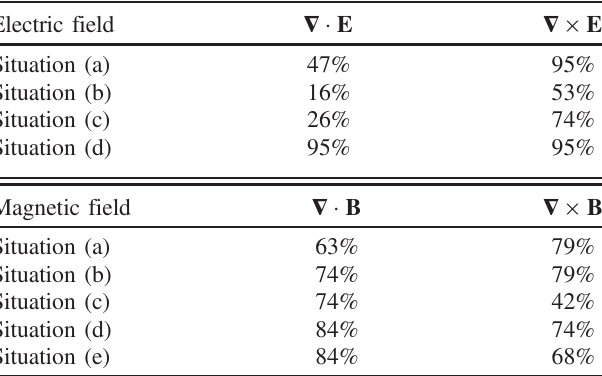
TABLE VI. The percentage of students who could correctly determine whether the divergence and curl of the electric (magnetic) field described in a situation is zero or not ð N ¼ 19 Þ . Electric